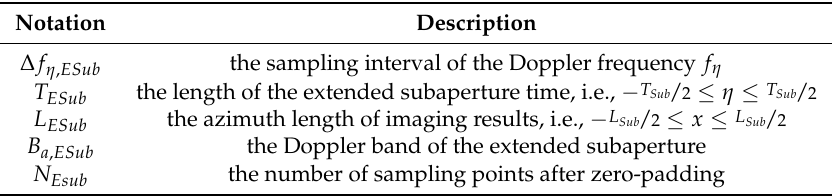
Table 3. Notations used in the extended subaperture